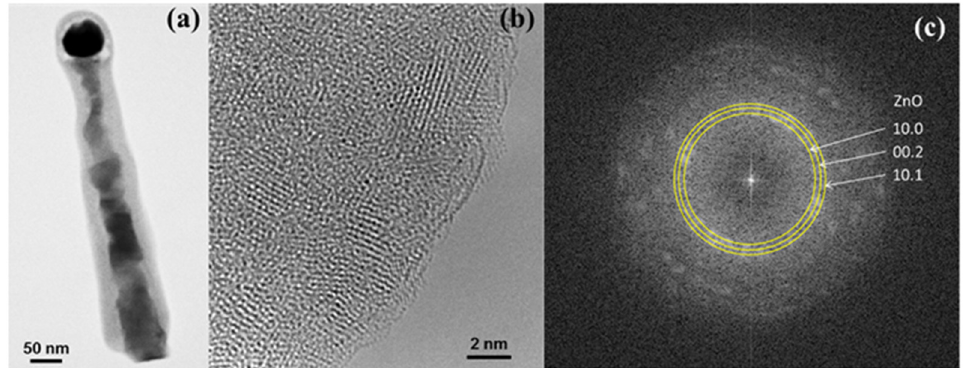
Figure 5. The TEM structure analysis of oxidized ZnTe/Zn nanowire, similar to these presented in Figures 1d and 2b. Panel ( a ) presents a general image of such NW, panel ( b ) shows a high resolution close up of the NW outer shell. ( c ) Modulus of the two-dimensional Furrier transform in logarithmic scale obtained for that part of the NW that is seen in ( b ). The Debye–Scherrer rings indicated in the panel correspond to ZnO crystal planes distances in the nanocrystallites.